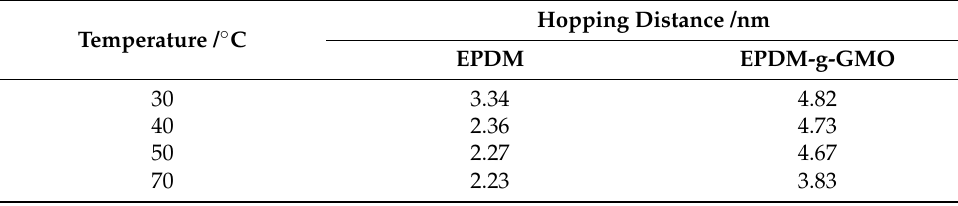
Table 5. Hopping distance of percolation conductance in EPDM and EPDM-g-GMO. Temperature / ◦